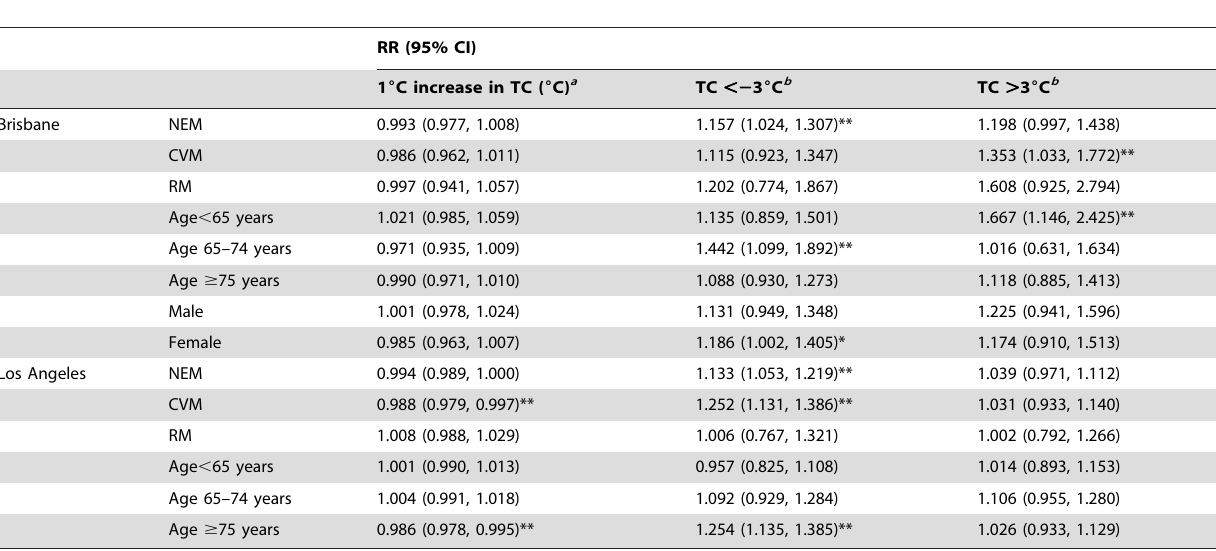
Table 3. The associations between temperature change and mortality in Brisbane, Australia and Los Angeles, United